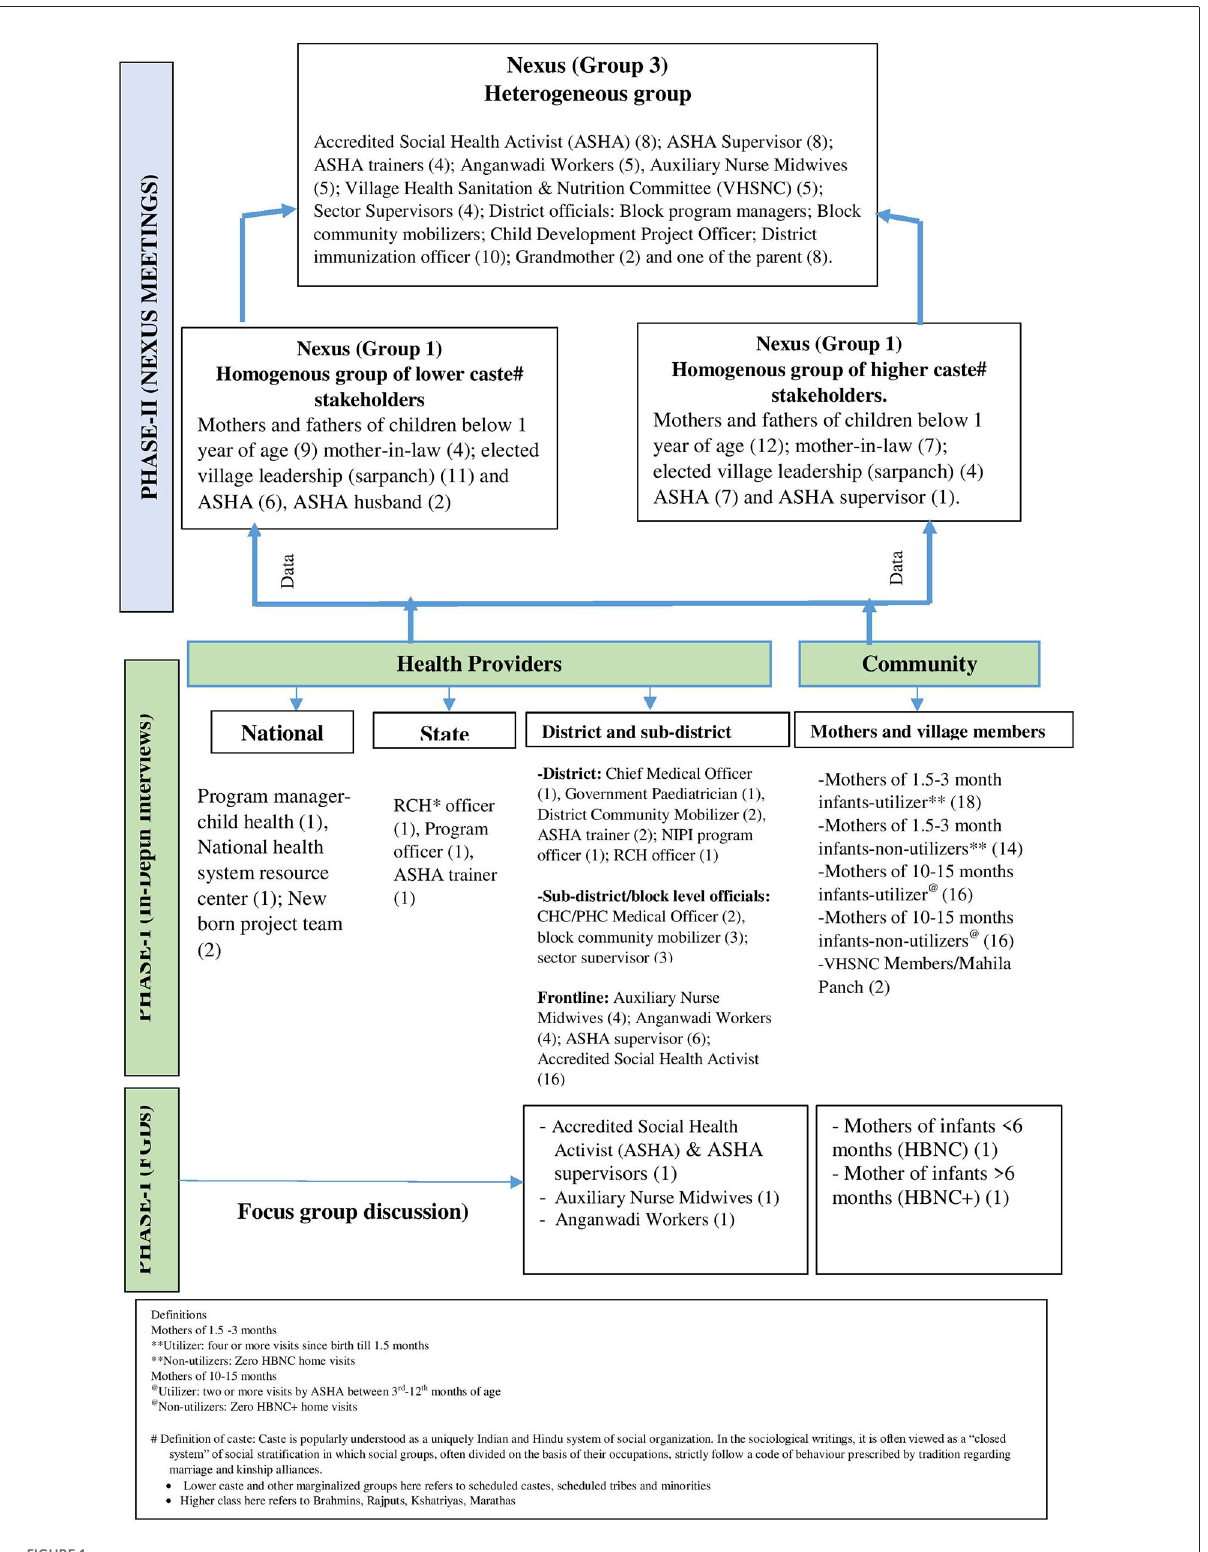
FIGURE1 Stakeholders involved in the